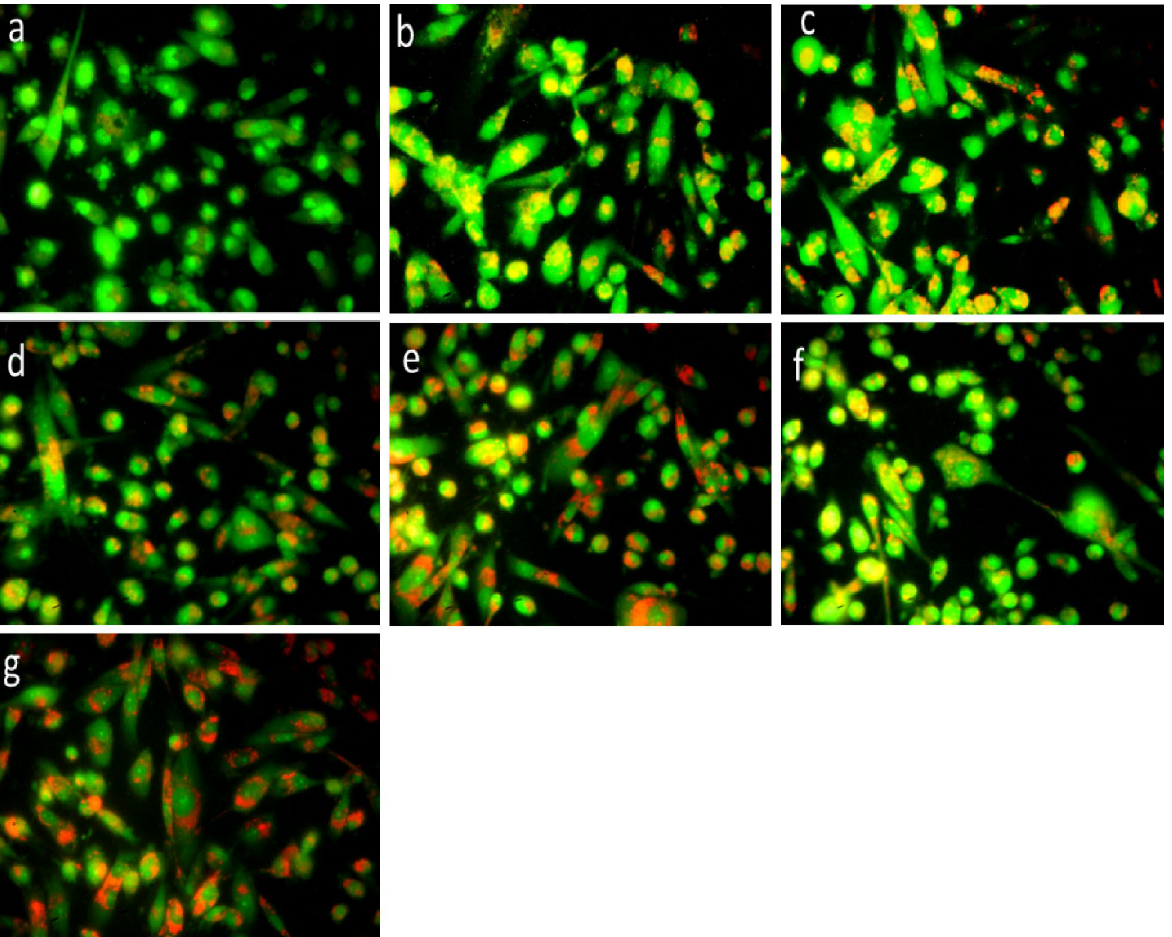
Figure 13. AO/ EB staining ( a ) Control; ( b ) 12.5 μg/ml SPIONs; ( c ) 15 μg/ml SPIONs; ( d ) 12.5 μg/ml papaya latex coated SPIONs; ( e ) 15 μg/ml papaya latex coated SPIONs; ( f ) 10 μg/ml drug loaded nanoconjugate; ( g ) 12.5 μg/ml drug loaded